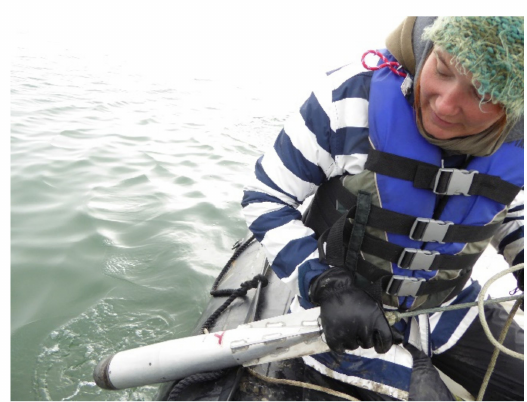
Figure 2. Portable free-fall penetrometer BlueDrop during YUKON14